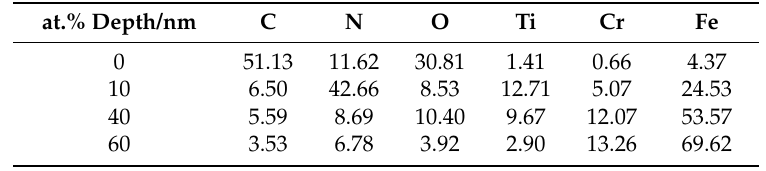
Table 2. Atomic concentrations of S1 at different depths.